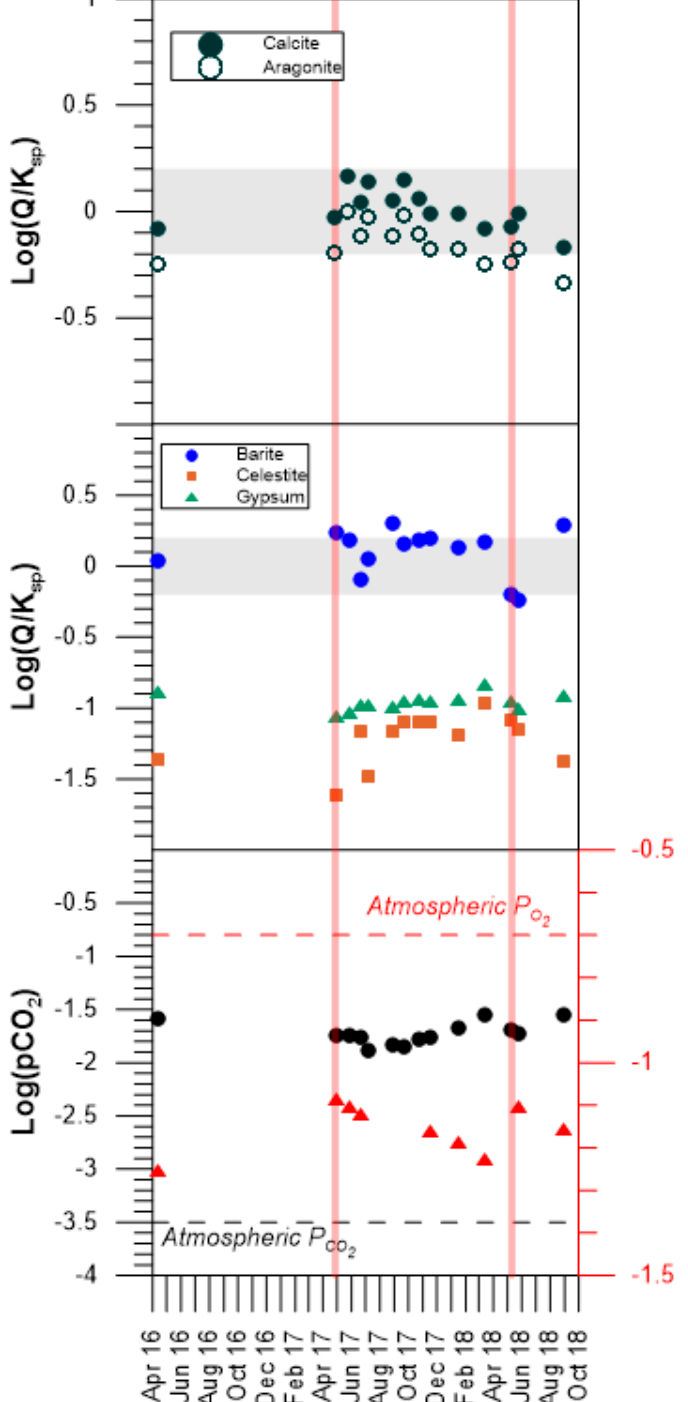
Figure 6. Saturation states of Ca-carbonates (calcite and aragonite) and of sulfate minerals (barite, celestite, and gypsum) along with the logarithm of the equilibrium CO 2 and O 2 partial pressures for the karstic spring. The shaded areas represent the saturation state range within which equilibrium is assumed (±0.2). The dashed lines are the atmospheric CO 2 and O 2 partial pressure (log pCO 2 (atm) = − 3.5; log pO 2 (atm) = − 0.7). The two vertical lines point to the dates of salinity minima. Note the missing celestite datum for May 2017 (Table 1).